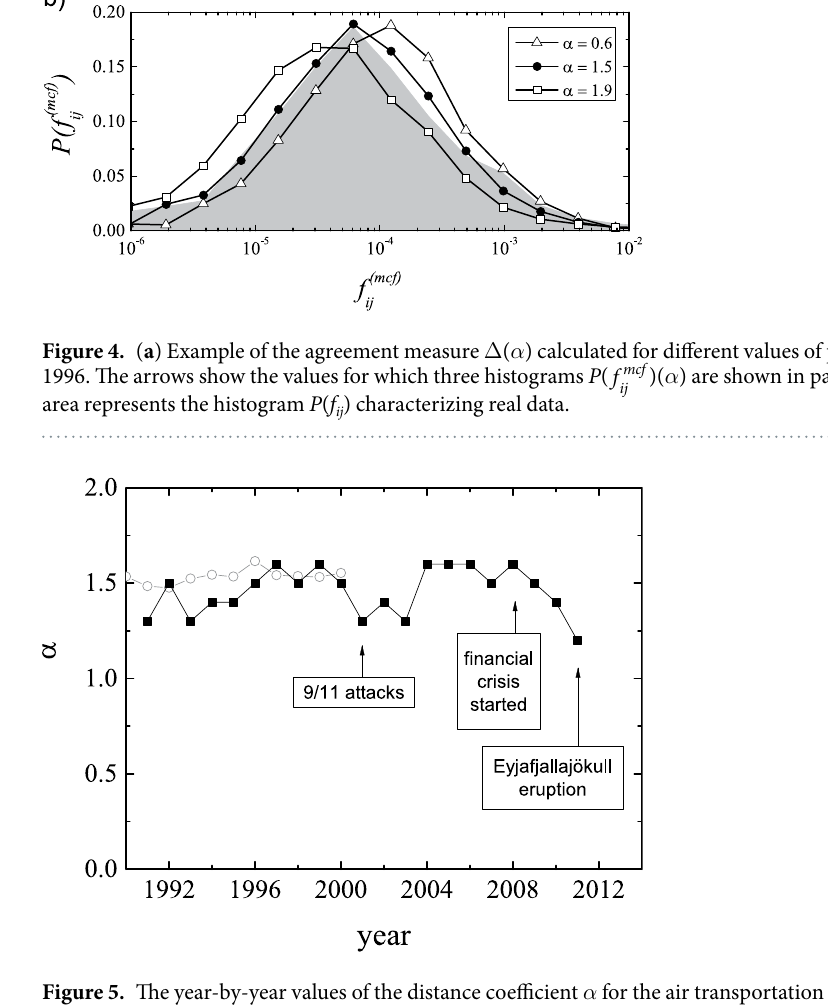
Figure 5. The year-by-year values of the distance coefficient α for the air transportation network resulting from the minimalization of the measure Δ ( α ) (black squares) and for the world trade network taken from a previous paper 17 (grey